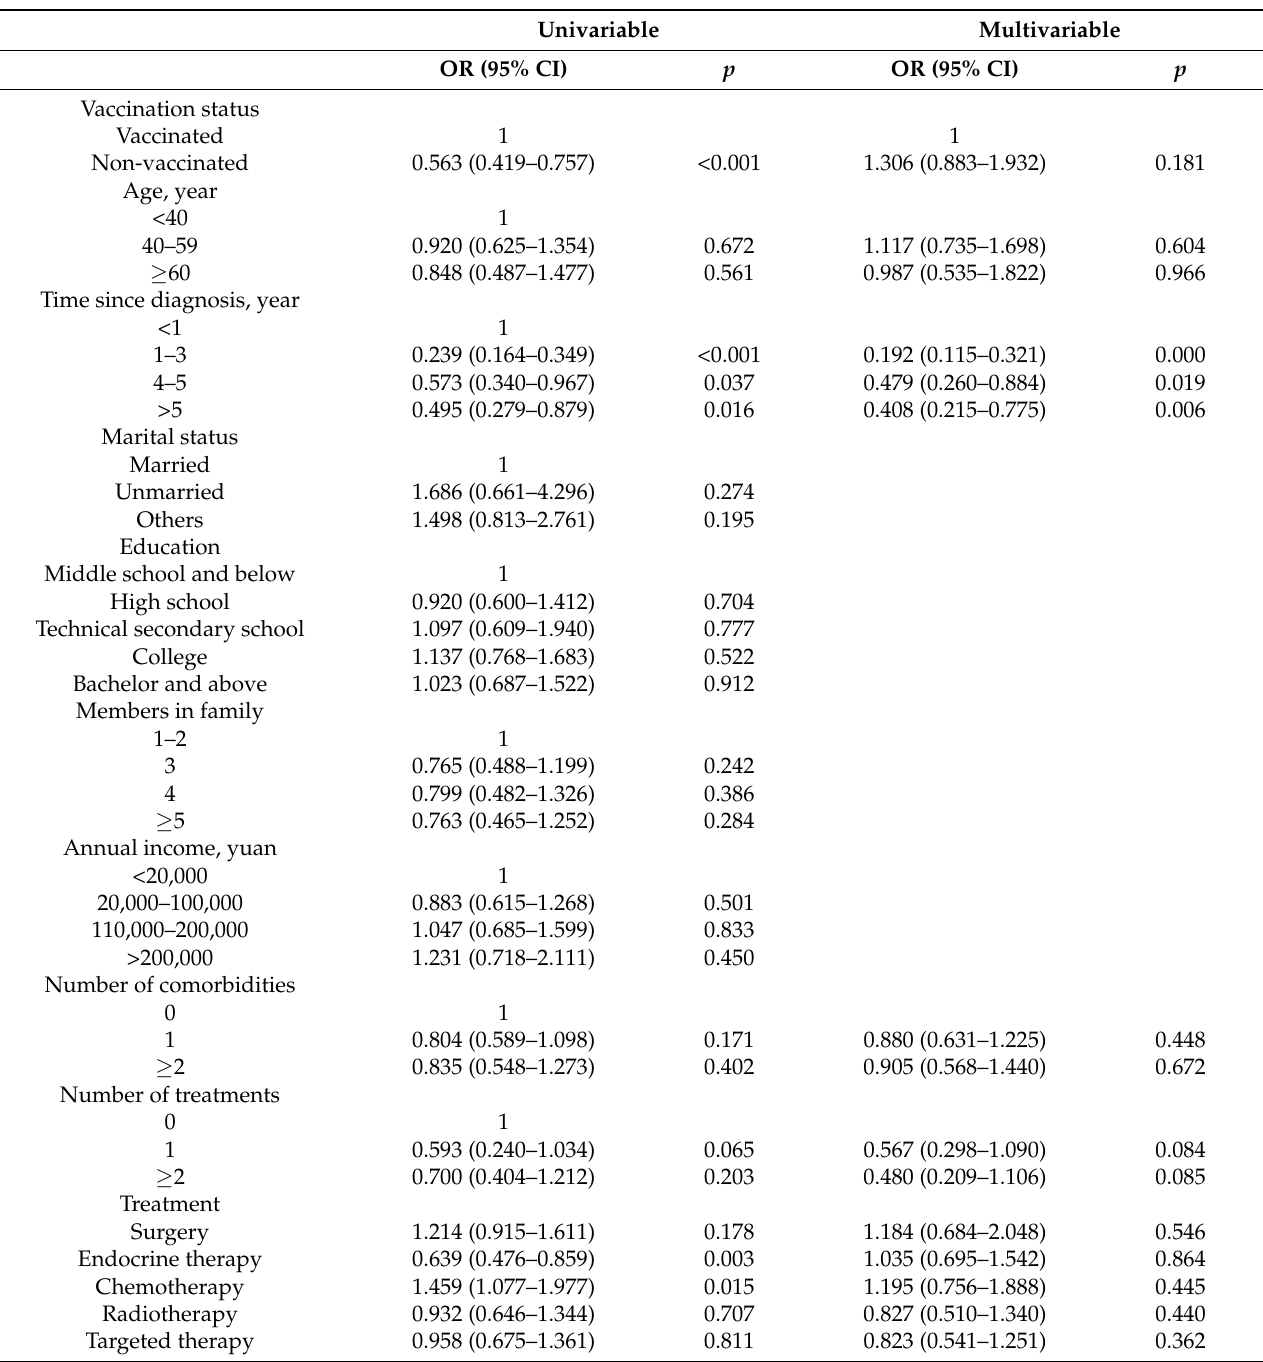
Table 3. Univariable and Multivariable logistic regression for vaccine hesitancy.